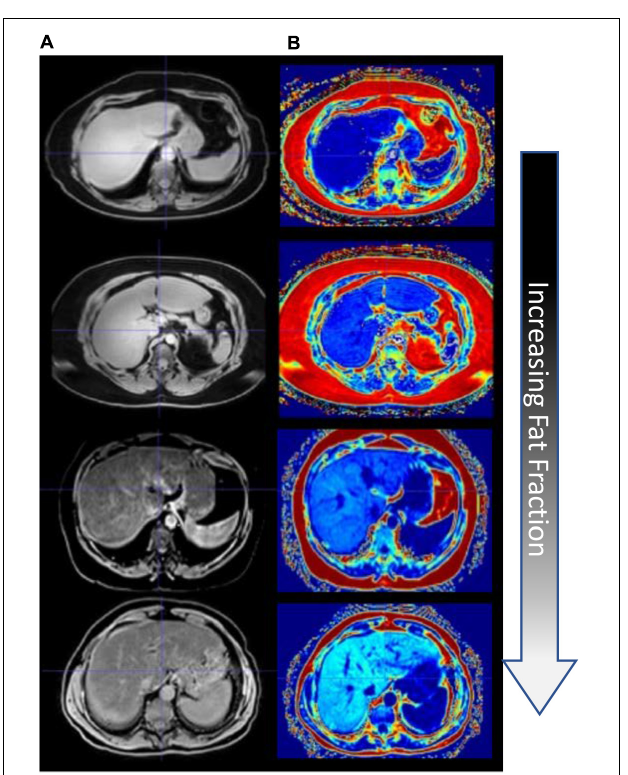
FIGURE 2 | Fat quantification imaging of the liver. (A) mDixon water image. (B) mDixon fat fraction images (hyperintensity levels indicating increasing fat